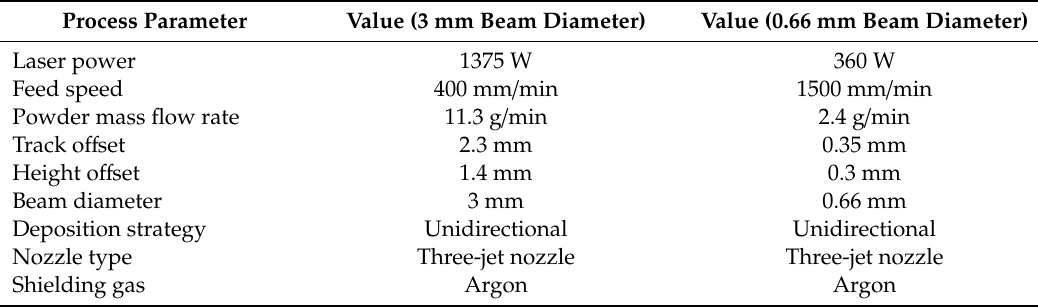
Table 4. HiperFer AM laser metal deposition (LMD) process